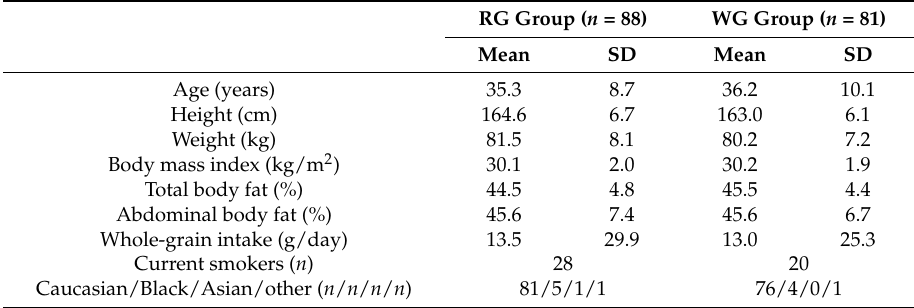
Table 1. Baseline characteristics of the participants (visit 1) in the whole-grain (WG) and refined-grain (RG) groups (mean values and standard deviations